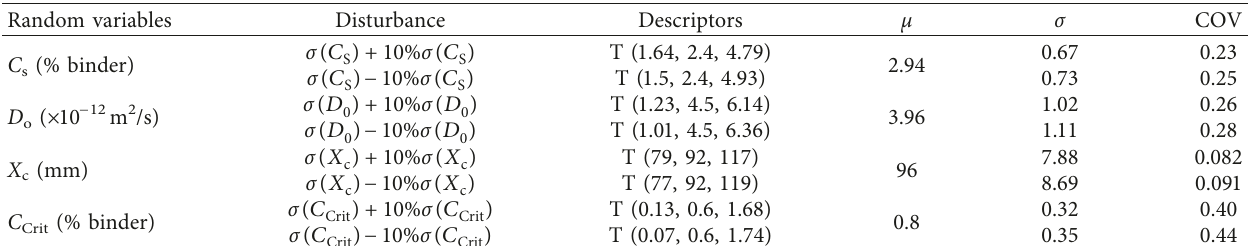
Table 8: Descriptors for sensitivity analysis of the standard deviation of four random variables. Random variables